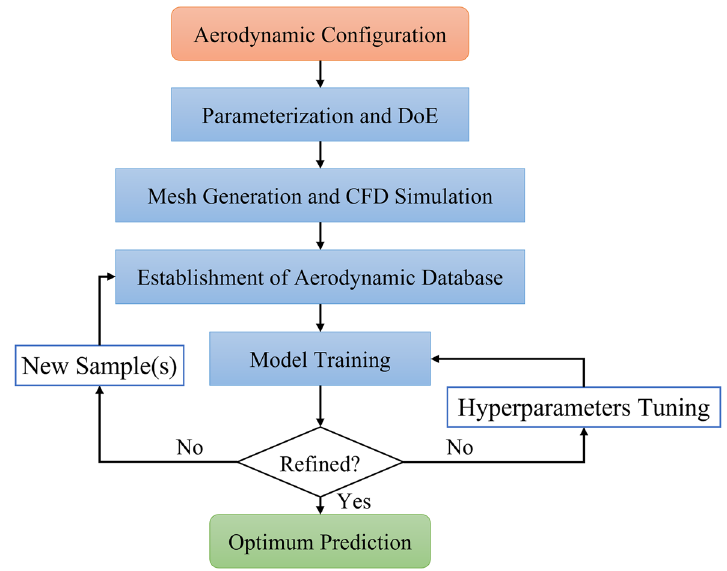
Fig. 4 Aerodynamic data modeling